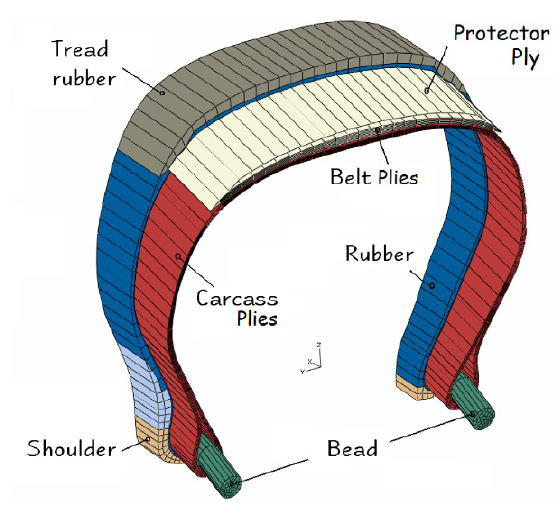
Figure 5. Finite Element Model and tire structure